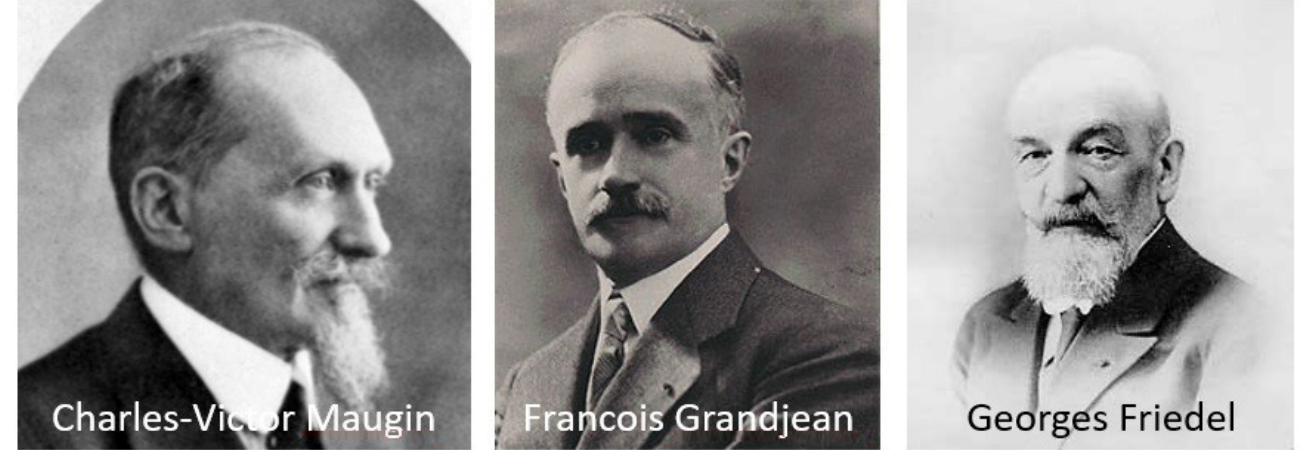
Figure 2. The French liquid crystal researchers of the early days: Charles Maugin, Francois Grandjean, and Georges Friedel.